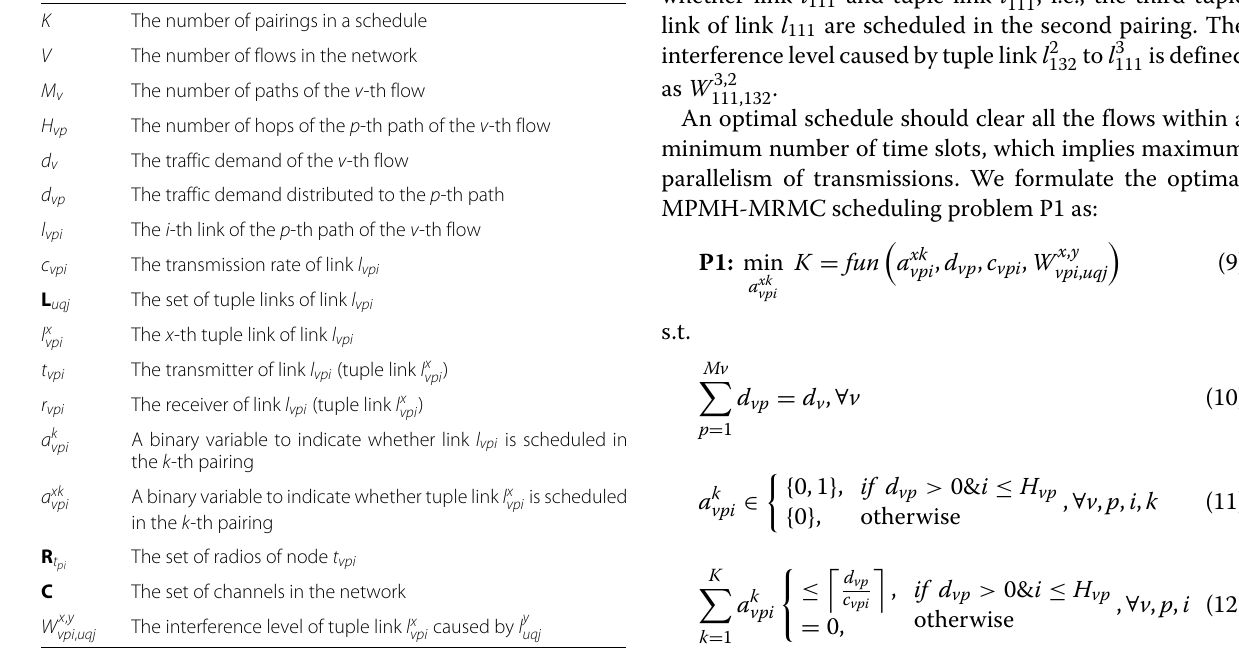
Table 1 Notation in problem formulation